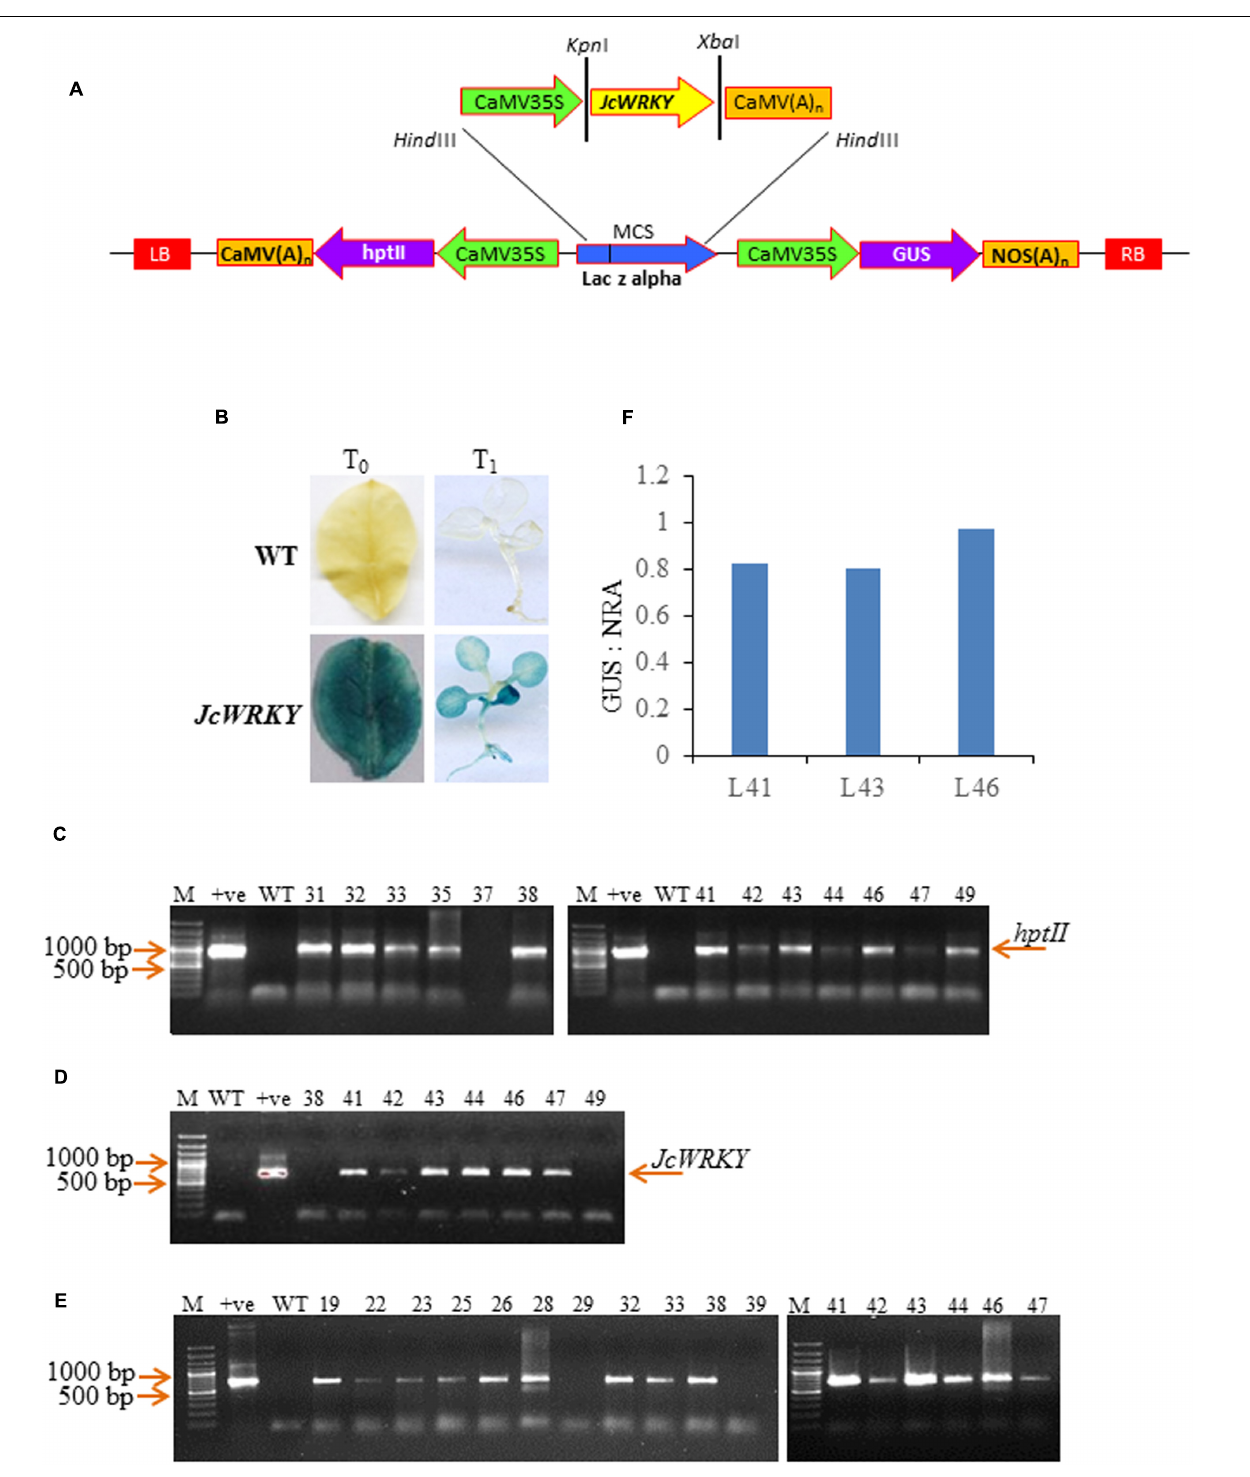
FIGURE 1 | Characterization of JcWRKY transgenic tobacco plants. (A) Schematic representation of the pCAMBIA1301 – 35S: JcWRKY construct used for Nicotiana tabacum transformation. (B) GUS assay of T 0 leaf and T 1 seedlings showing positive expression in the transgenic lines and negative expression in WT plants. PCR confirmation of transgenic lines (lane number denote transgenic line number) with (C) hptII (964 bp) and (D) JcWRKY (693 bp) primers. (E) Reverse transcriptase PCR of WT and JcWRKY transgenics. Amplification was observed with some transgenics, while no amplification with WT. Actin gene was used as an internal control. M refers to 100 bp plus ladder (MBI Fermentas). (F) GUS: NRA ratio for determination of copy number of transgene in tobacco plants.